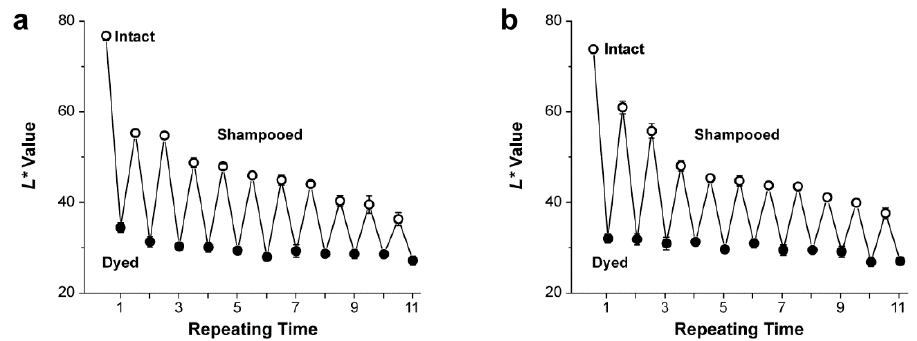
Figure 3. Graphs of L * values for repeated dyeing and shampooing in the spraying protocol. ( a ) Argan oil ‐ based emulsion (pH 5). ( b ) Ylang ‐ ylang oil ‐ based emulsion (pH 5).